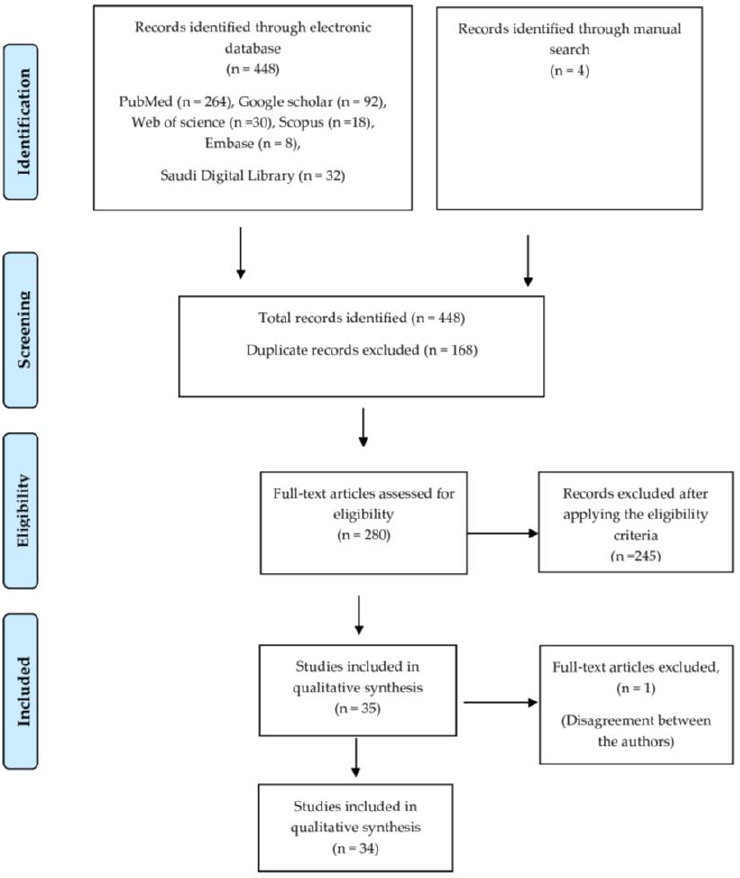
Figure 1. Flow chart for screening and selection of articles.